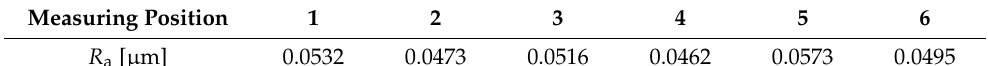
Table 2. Measurement results of surface roughness of substrate.